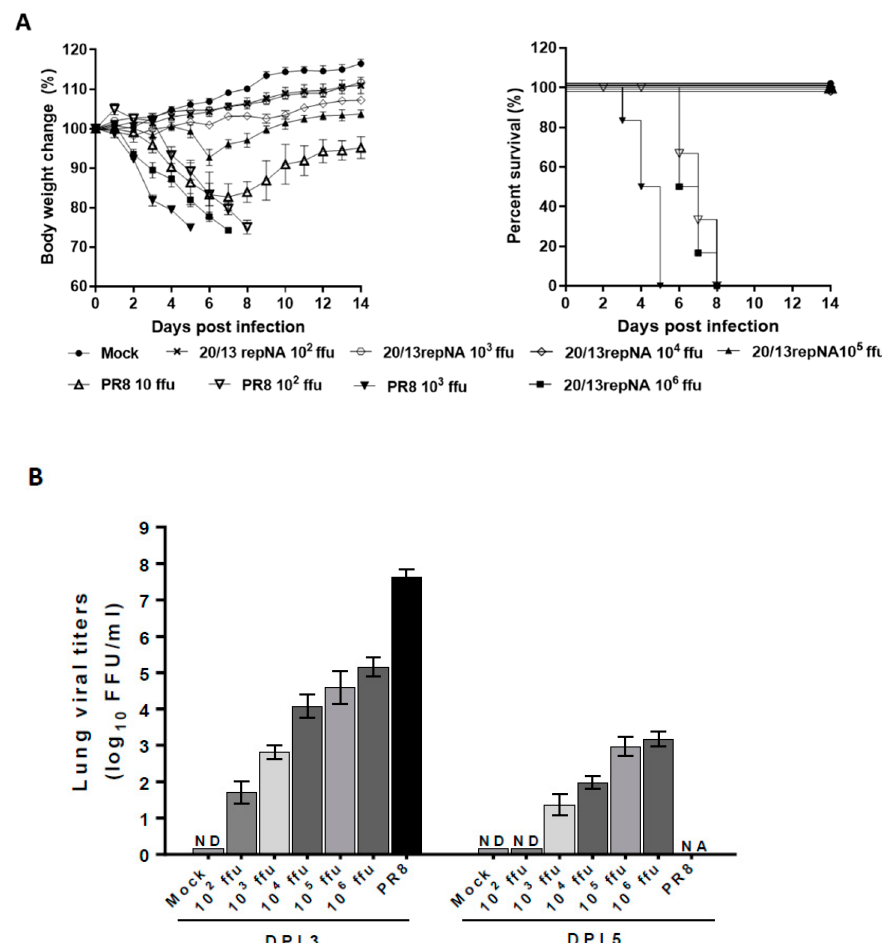
Figure 4. Pathogenicity of 20/13repNA virus in mice. Groups of BALB/c mice were infected intranasally with different doses of the 20/13repNA virus (10 2 ~10 6 ffu) or wild-type PR8 virus (10~10 3 ffu). Mice treated with PBS were used as controls. ( A ) Body weight (left panel) and survival (right panel) were monitored for 14 days ( n = 6). Body weight data represent mean ± SEM. ( B ) Lungs were harvested from mice ( n = 3) at 3 and 5 dpi with different doses of the 20/13repNA virus and 10 3 ffu of the PR8 virus. Viral titers were determined by plaque assays on MDCK cells. Symbols represent data from individual mice. ND, not detected (detection limit, 10 ffu/mL/lung). NA, not applicable (all mice infected with the PR8 virus died within 5